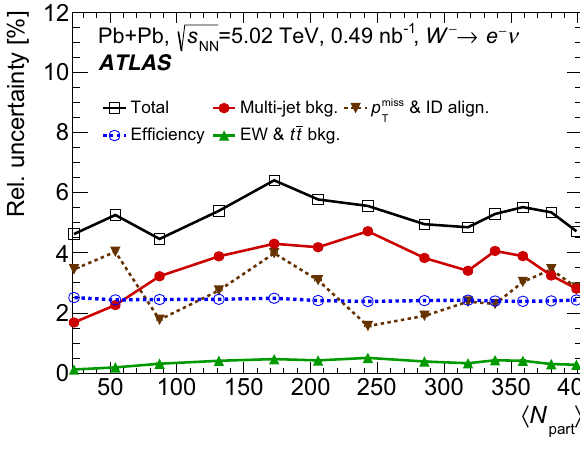
Fig. 5 Relative systematic uncertainties of W + (left) and W − (right) boson production yields measured in the electron decay channel eval- uated as a function of (cid:4) N part (cid:5) . The total systematic uncertainty is represented by open squares, while other markers represent contribu- tions from individual sources of uncertainty. The uncertainties related